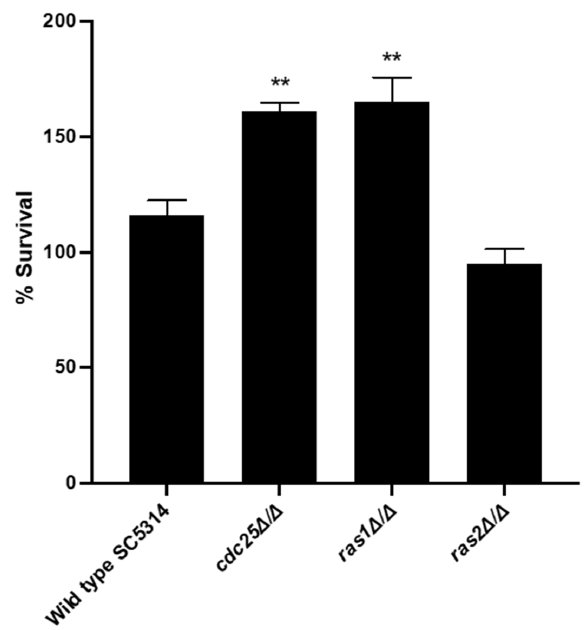
Figure 6. Cdc25 and Ras1 have a negative effect on the survival of C. albicans cells in the presence of macrophages. C. albicans cells were cocultured for three hours with BMDMs at 37 °C. Afterwards, the fungal cells were plated to check for their survival. The results show the average of three independent experiments each consisting of one biological repeat and three technical repeats with the error bars representing the SEM. Statistical analysis was done by using an ANOVA test with Bonferroni correction. A significant difference was found when ** p = 0.0021.